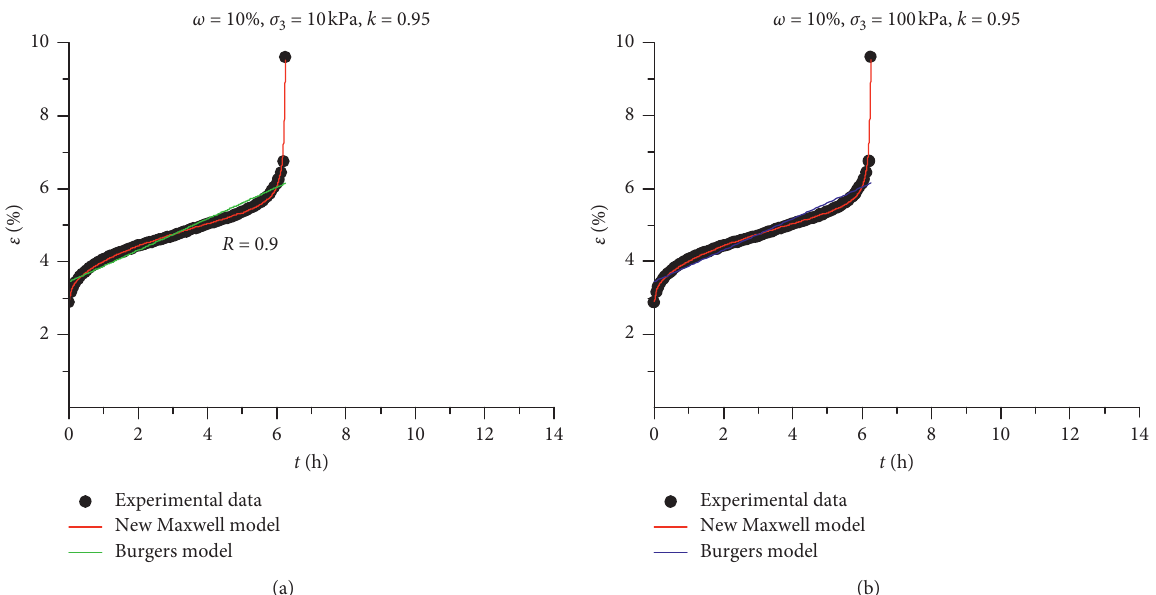
Figure 11: Comparison between theoretical and experimental curves of (a) new Maxwell model and Burgers model and (b) new Maxwell model and Nishihara